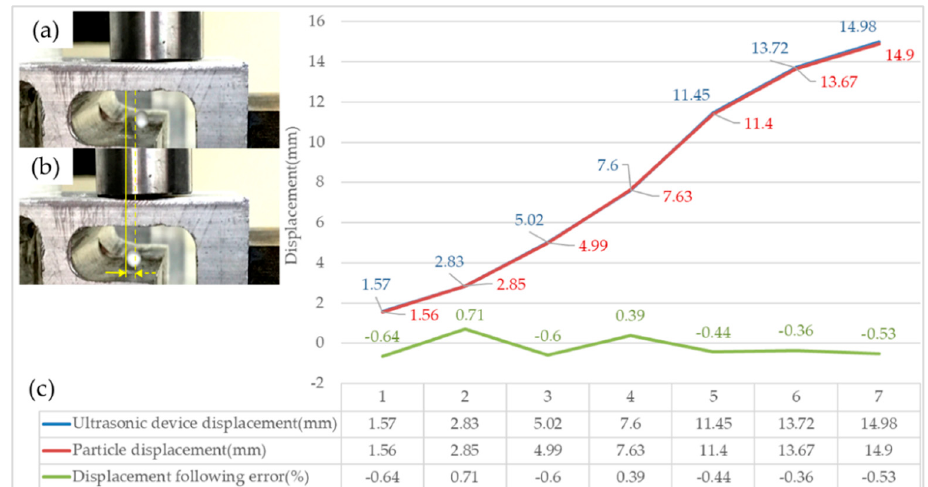
Figure 8. Particle displacement motion: ( a ) Diagram of the initial position; ( b ) Diagram of the micro-displacement change; ( c ) Diagram of the table of the particle displacement following error.